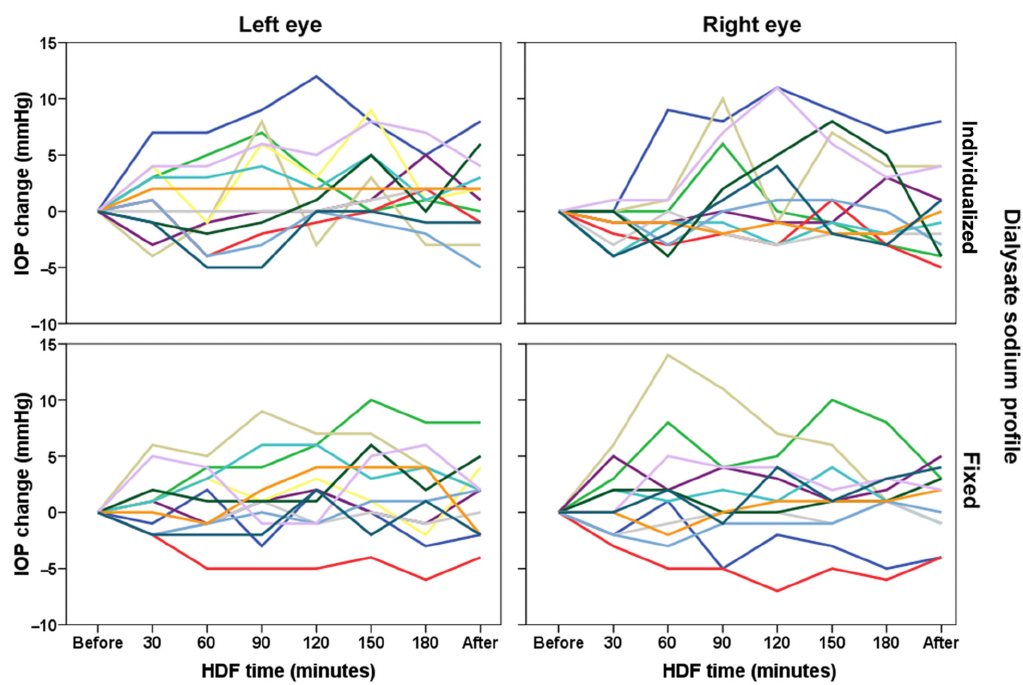
Figure 2. Individual values of intraocular pressure evaluated during hemodiafiltration (HDF) in 13 patients (each color indicates a different patient) with different dialysate sodium profile (individualized or fixed at 138 mmol/L).